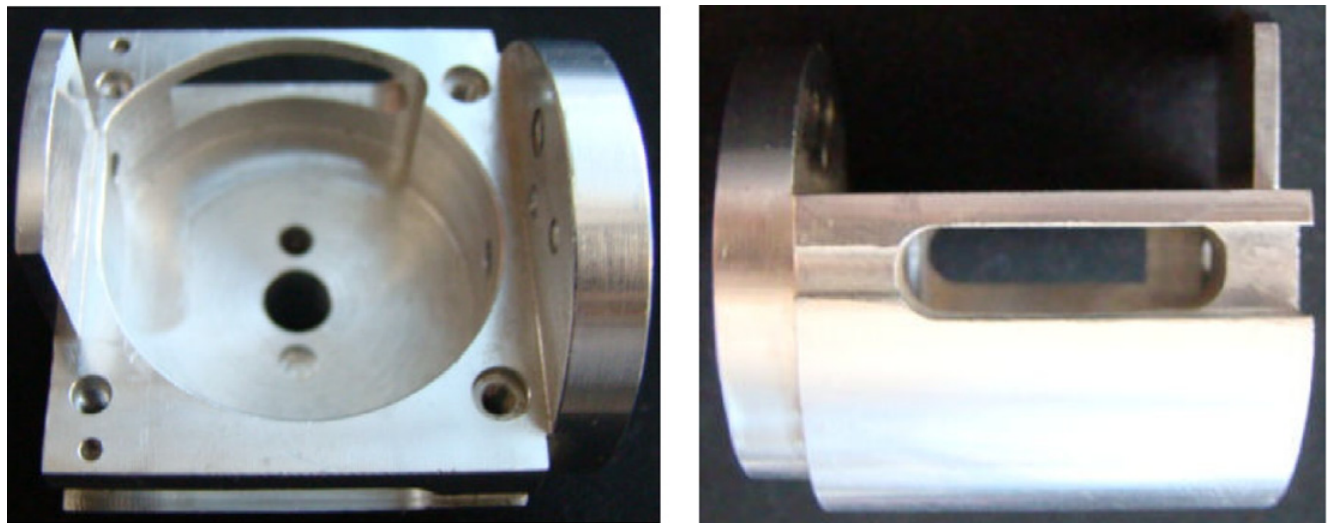
Fig 2. The complicated sample. The thickness is the notable difference. The bottom is solid, the center is hollowed-out, and the top is irregular.